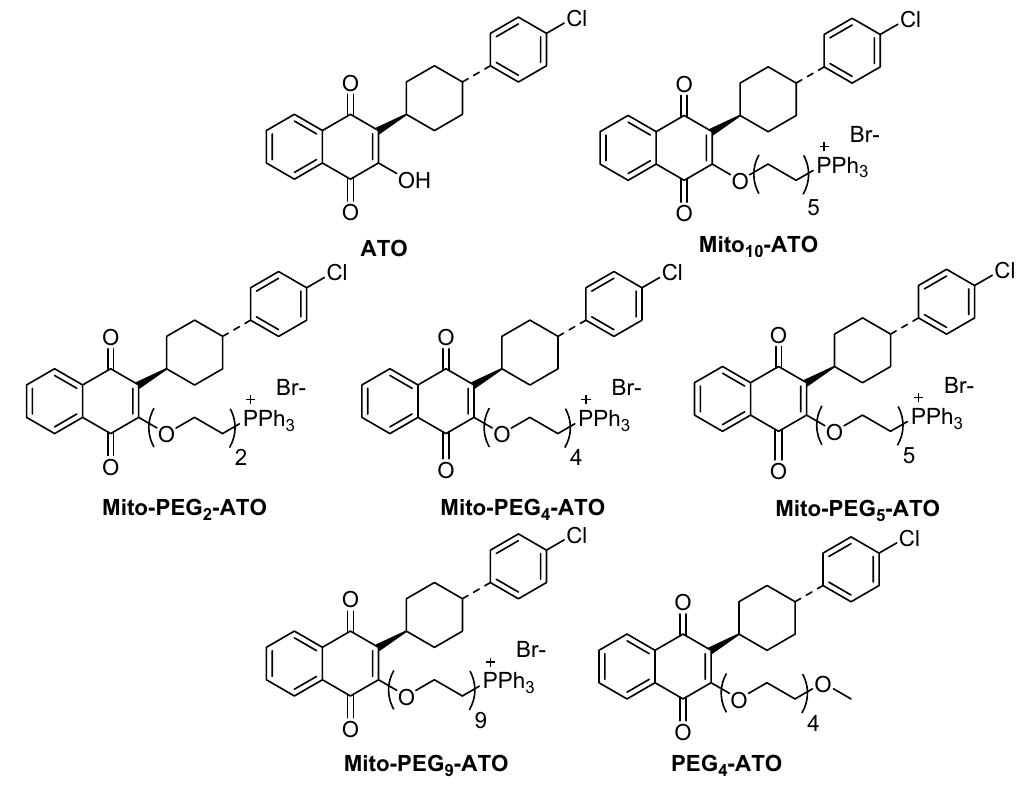
Figure 1. Chemical structures of Mito-PEG-ATO analogs and related